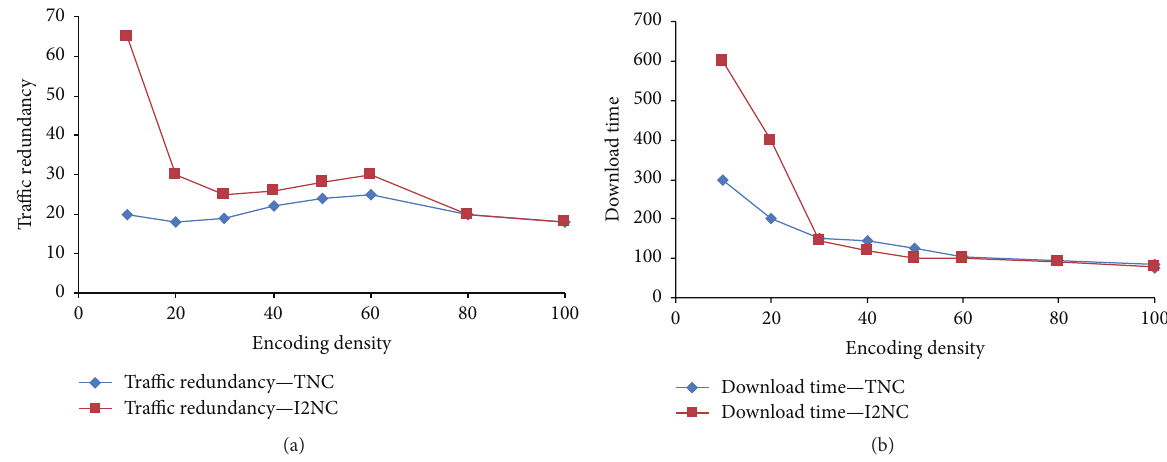
Figure 7: (a) Impact of encoding density in traffic redundancy. (b) Impact of encoding density in download